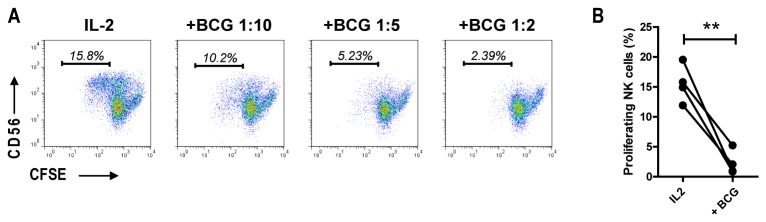

M.
bovis BCG inhibits IL-2 induced
proliferation of CD56bright NK cells.A) Purified NK cells from a healthy human donor were labelled with CFSE
and cultured for 7 days in the presence of IL-2 (100U/ml) +/-
M.
bovis BCG at various MOI before flow
cytometry analysis. Dose dependent inhibition of NK cell proliferation
by mycobacteria was observed. B) Joined dot plot illustrating the
reproducibility of NK cell proliferation inhibition by mycobacteria
across different NK cell preparation across independent donors (n=4,
paired t test, **p<0.01).